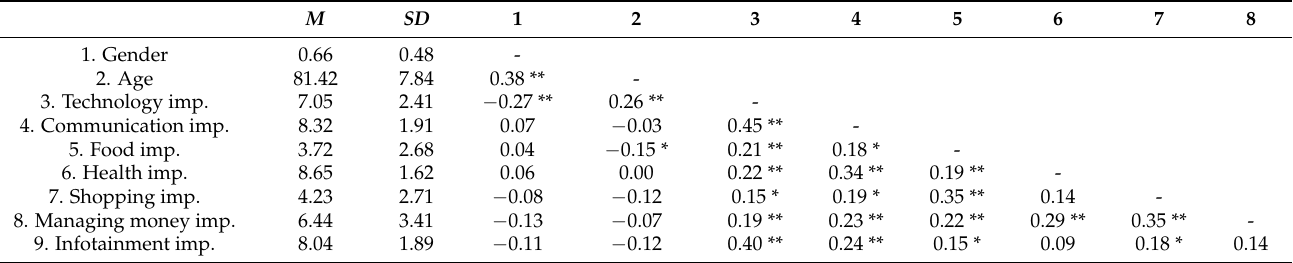
Table 1. Means, standard deviations, and correlations between indicator